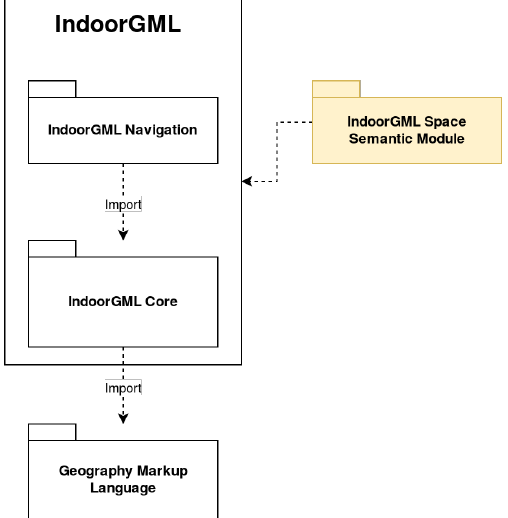
Figure 8. UML Package diagram showing the existing IndoorGML modules with the proposed